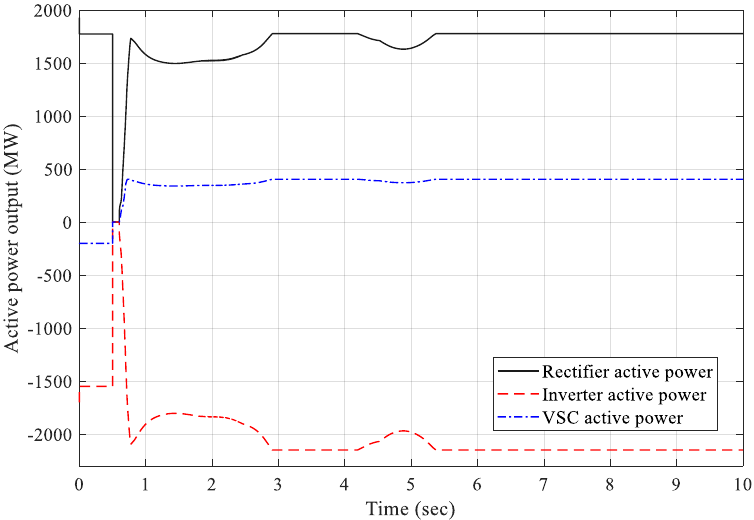
Figure 23. The active power output of each converter for the load side event with the operation strategy in the actual system data.